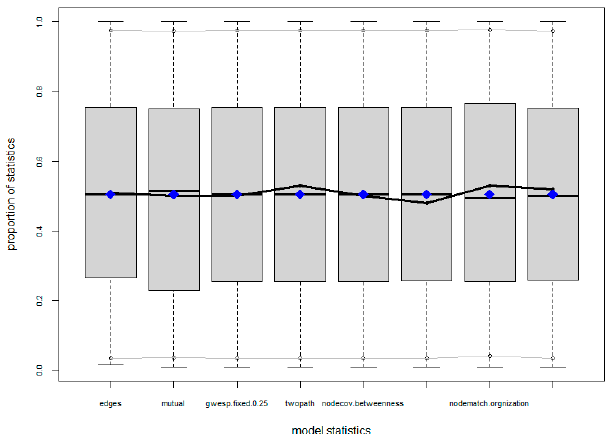
Figure 2. Robustness test results.